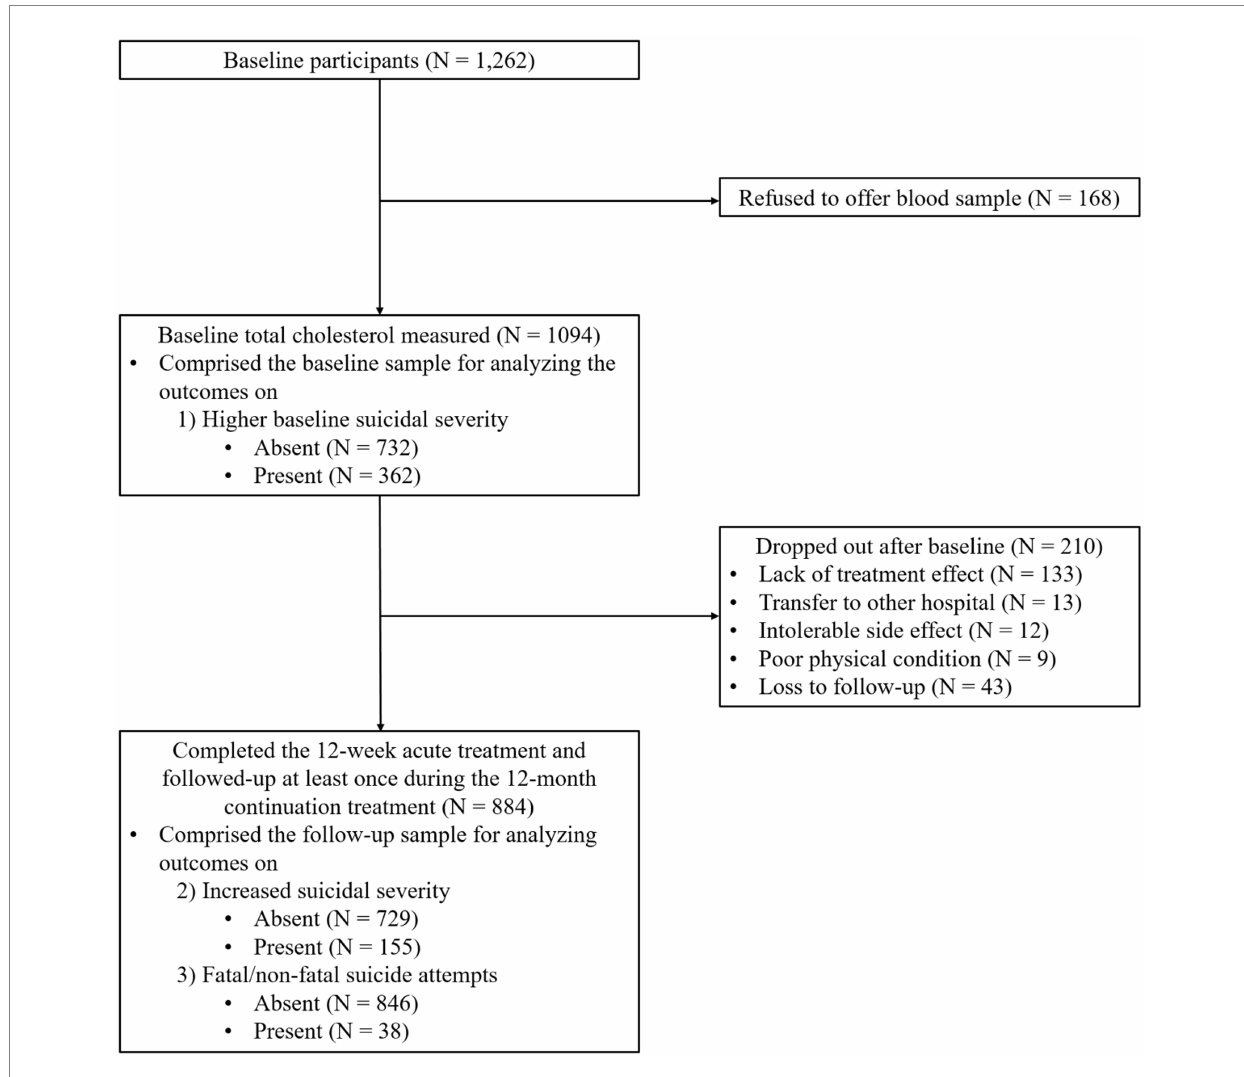
FIGURE 1 Participant recruitment and